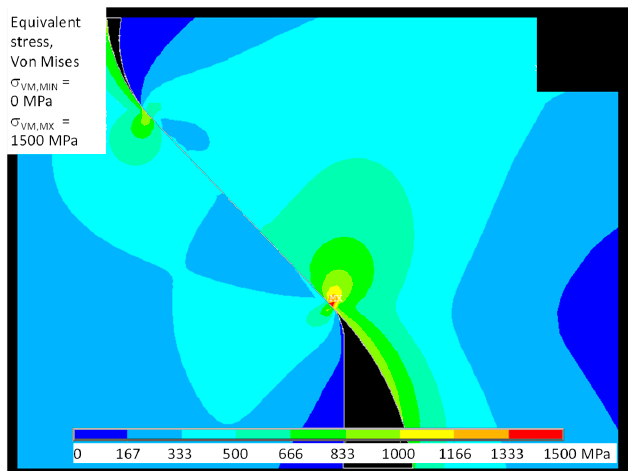
Figure 11. FE model of test # 2: Von Mises stress.